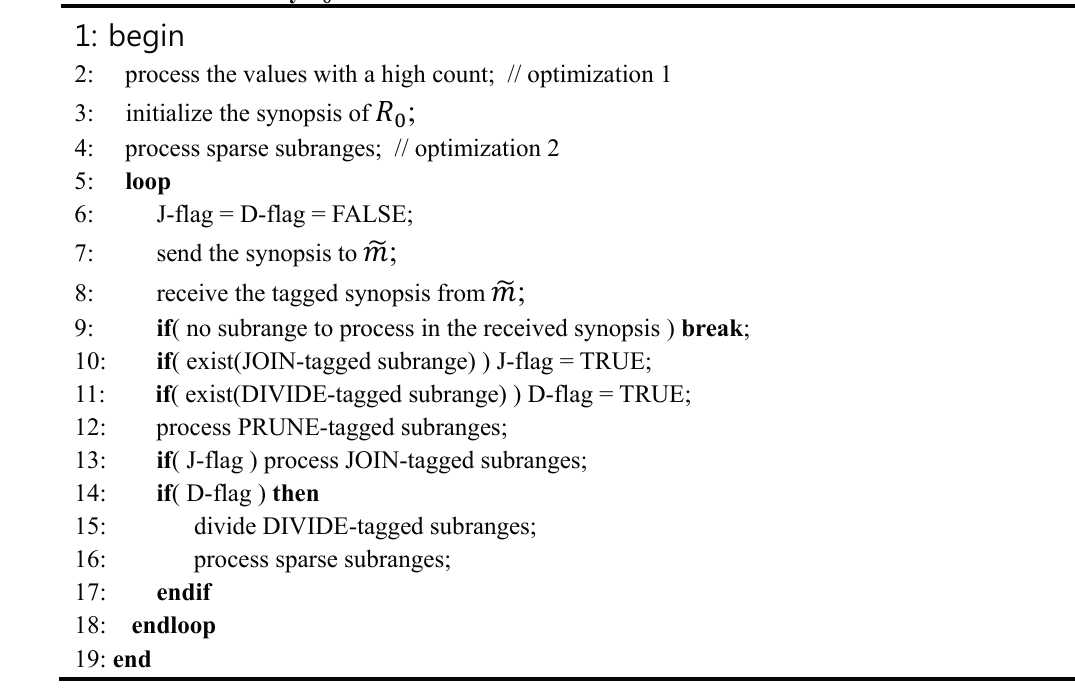
Figure 2. Protocol Executed by (cid:2196)(cid:3557)